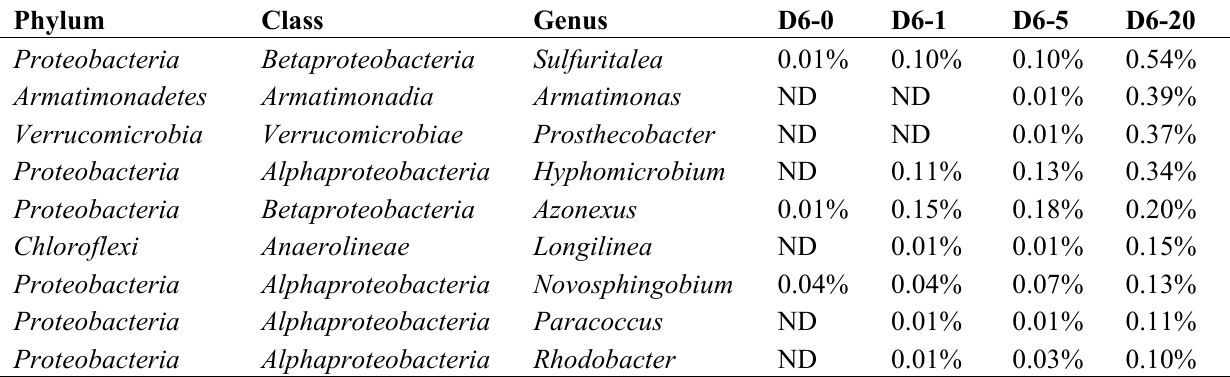
Table 2. Taxon composition profile of tetracycline resistant bacteria (TRB) in activated sludge.